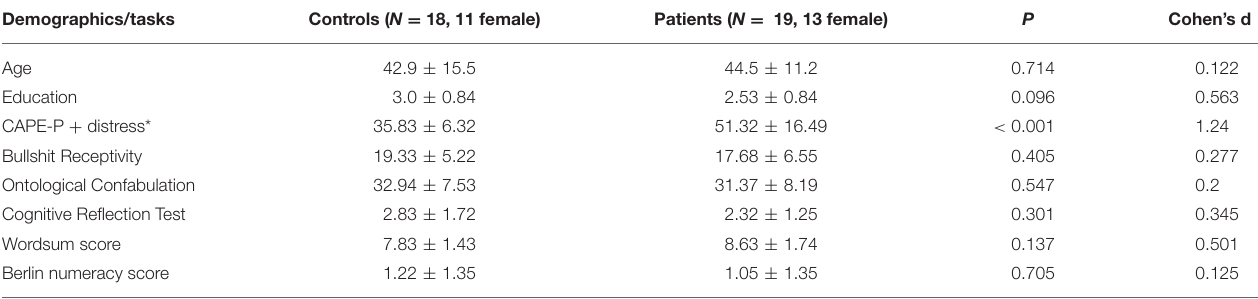
TABLE 2 | Demographics and task performance between controls and patients.